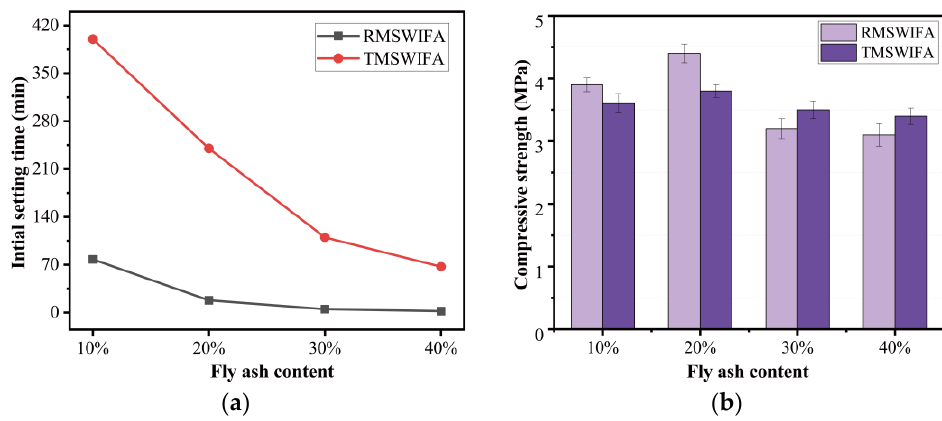
Figure 8. Effect of MSWI fly ash content on paste: ( a ) effect of MSWI fly ash content on the initial setting time of the paste and ( b ) effect of MSWI fly ash content on the paste strength.